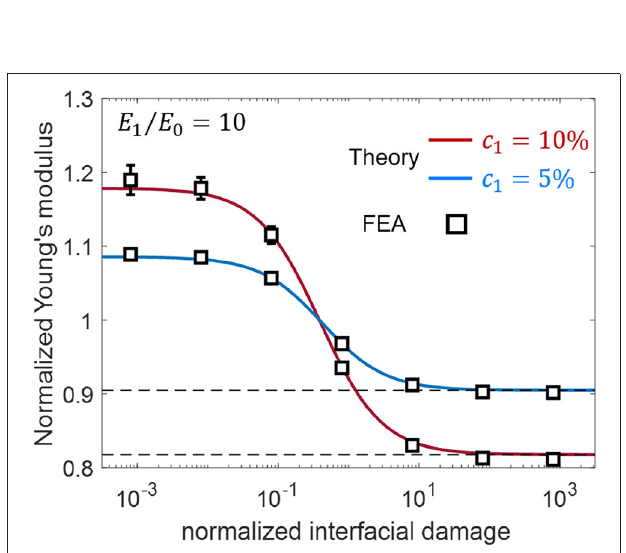
FIGURE 6 | Effective Young’s modulus of a composite with respect to the normalized interface damage parameter . The Poisson’s ratio of the two phases is 0.25 (Lee et al., 2019).